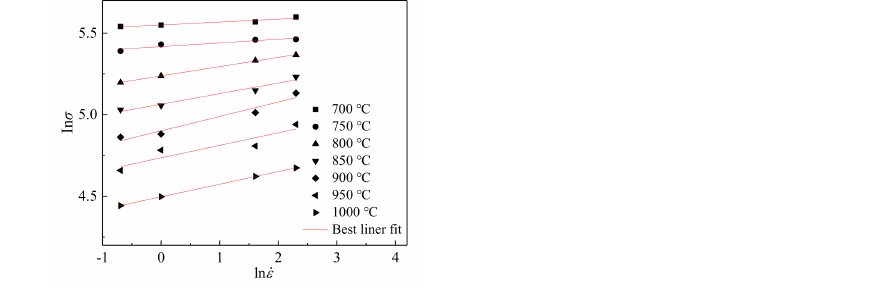
Figure 3. Relationship between flow stress and strain rate for alloy deformed at 900 ◦ C to